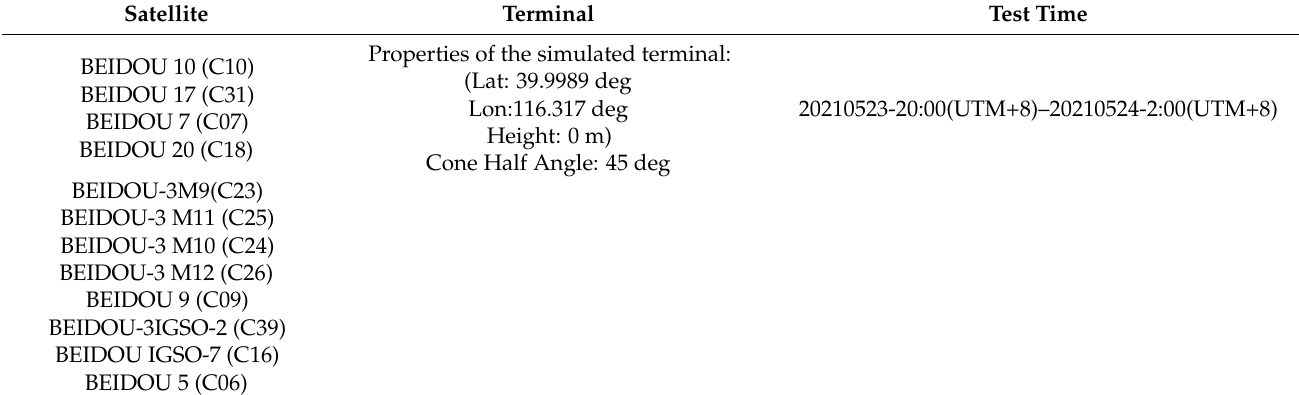
Table 1. Satellite data for experiments.